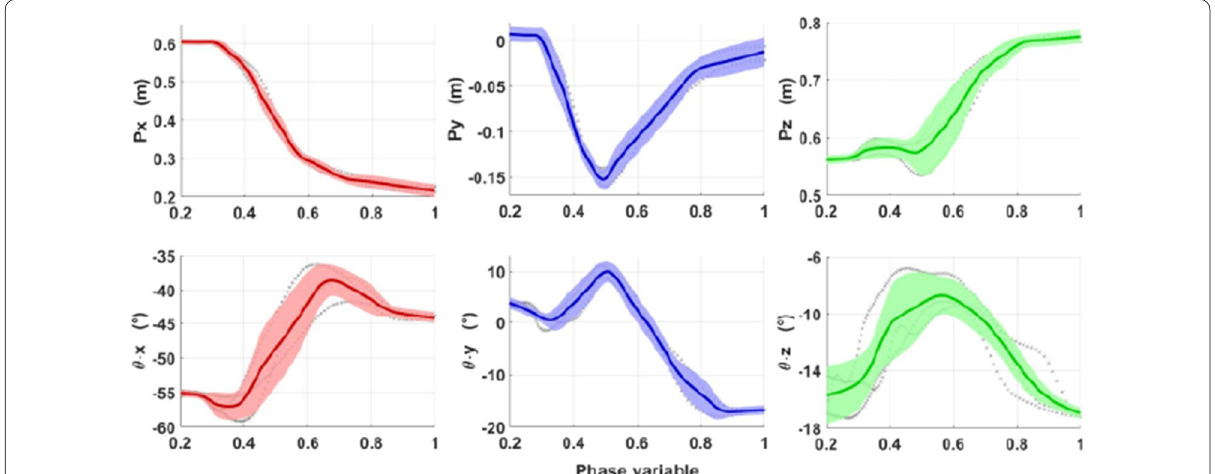
Figure 3 GMM-GMR for